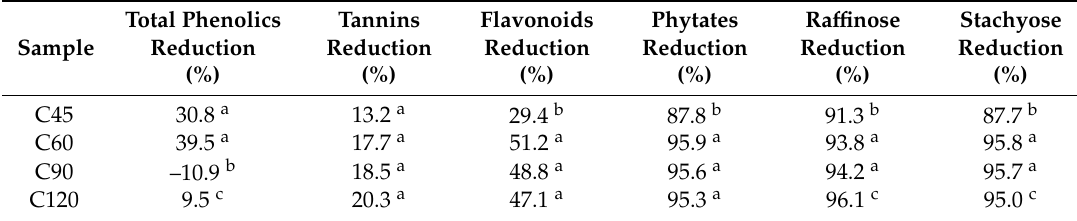
Table 4. E ff ect of cooking over total phenolics, condensed tannins, and flavonoids.